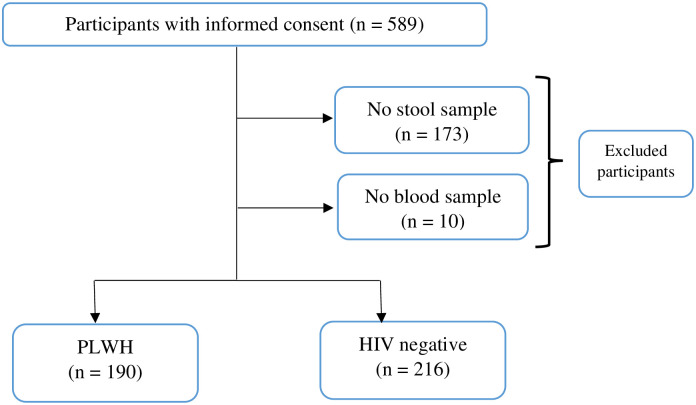
Study flow diagram showing compliance of the participants.